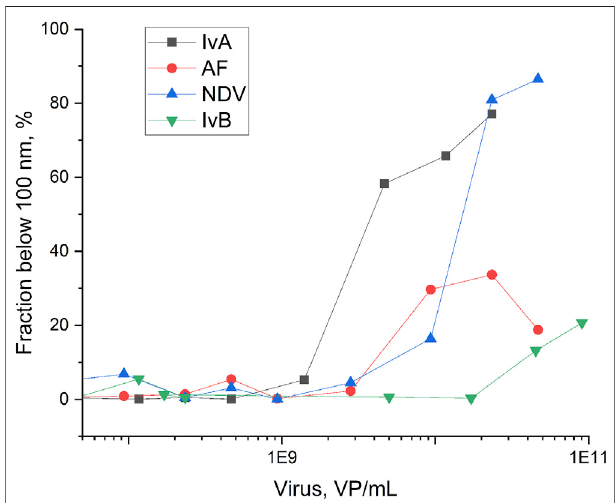
FIGURE 4 | Fraction of the aggregates of silver nanoparticles below 100 nm depending on the viral content. IvA – in fl uenza A virus, IvB – in fl uenza B virus, NDV – Newcastle disease virus, and AF – allantoic fl uid. The dilution of allantoic fl uid corresponds to the dilution of IvA.